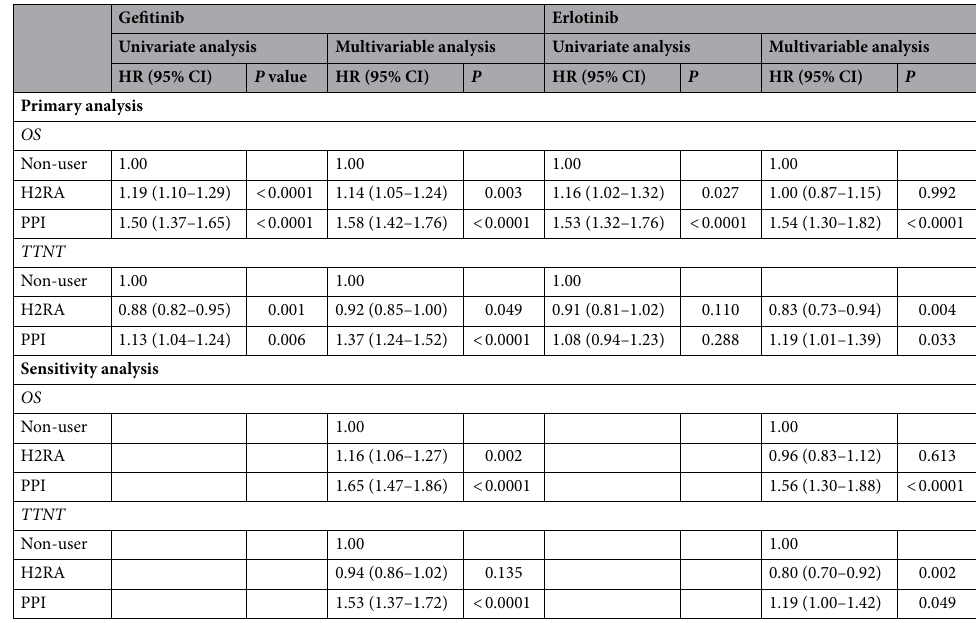
Table 2. Primary analysis and sensitivity analysis of overall survival (OS) and time to next treatment (TTNT) in the gefitinib and erlotinib